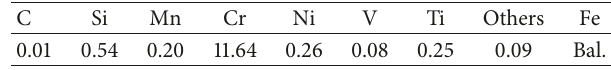
Table 1: Chemical composition of SUS 409L stainless steel sheets used in this study (mass %).